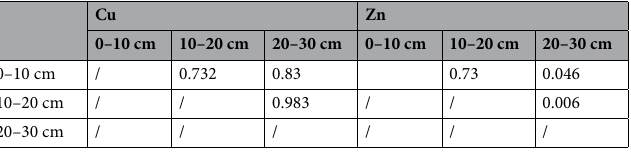
Table 3. Significant difference in the adsorption of Cu and Zn by sediments at different depths.